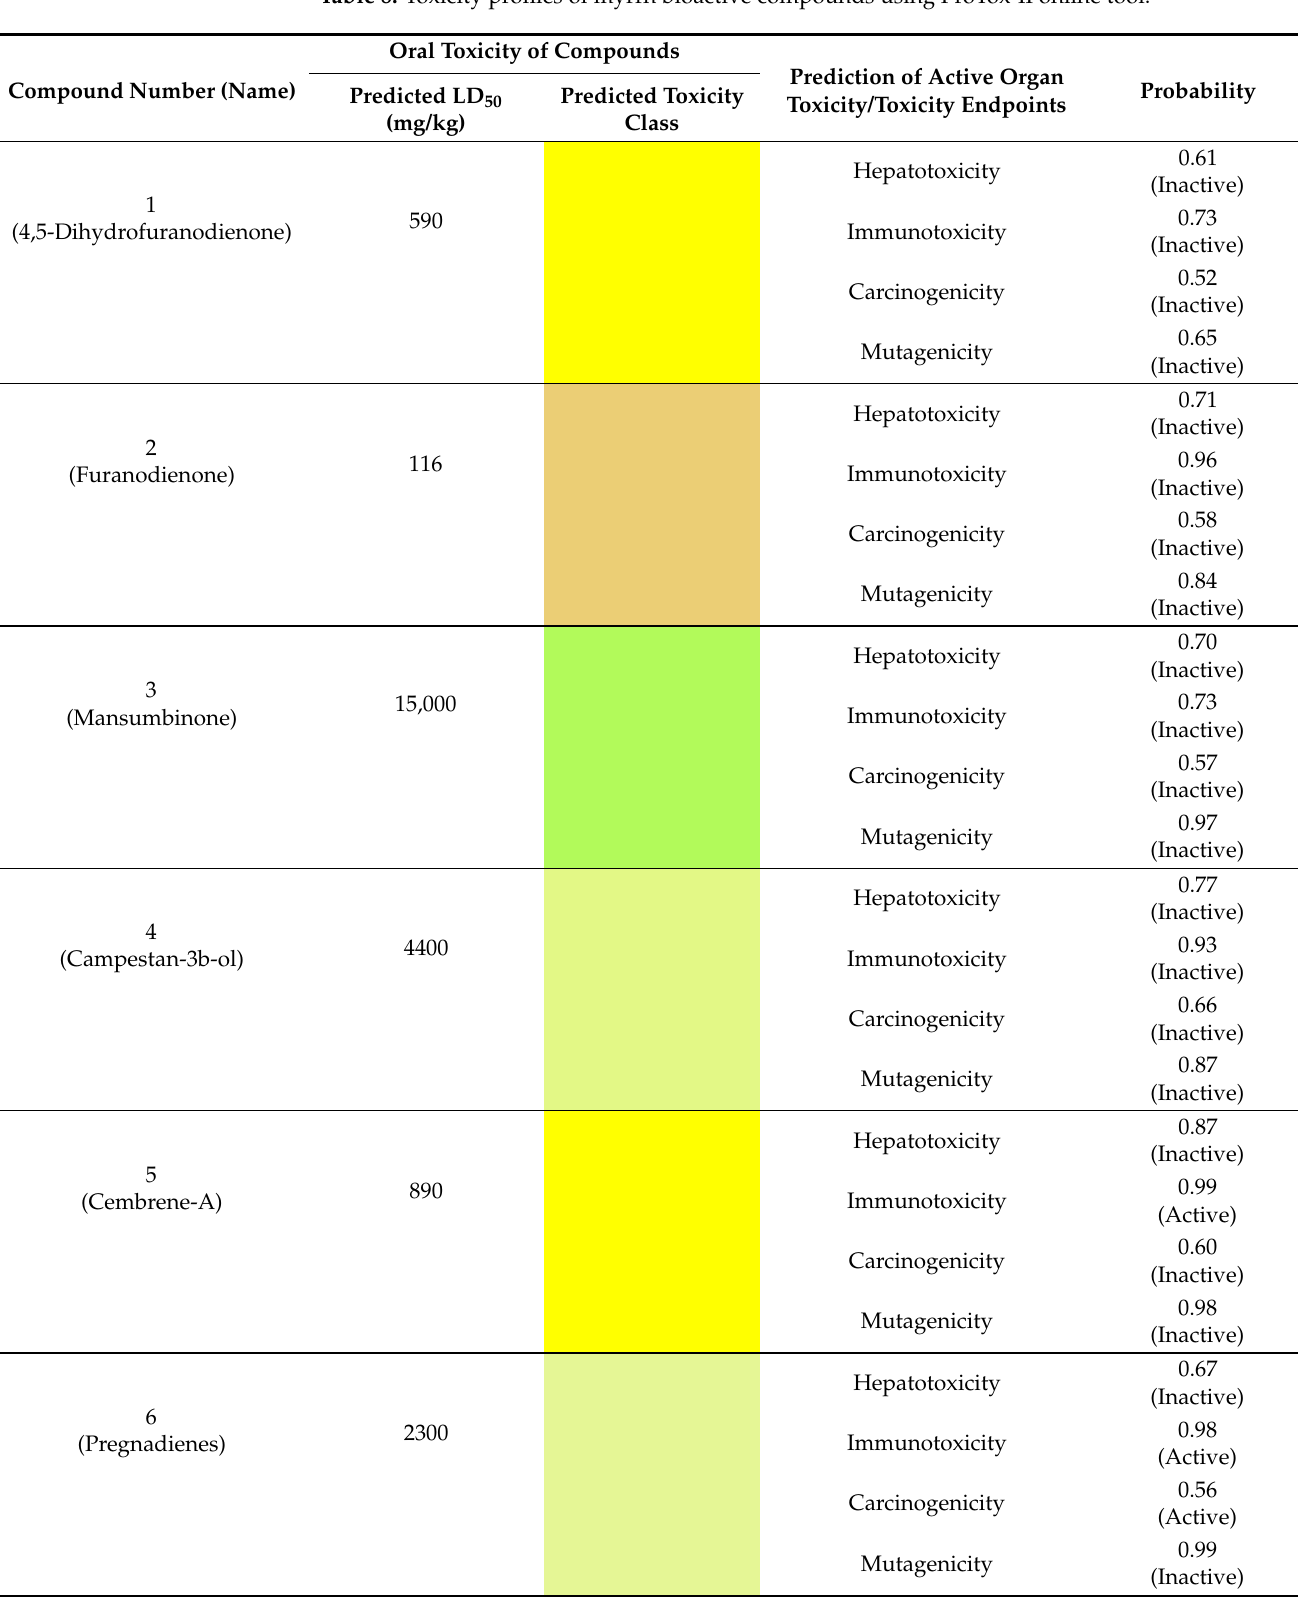
Table 8. Toxicity profiles of myrrh bioactive compounds using ProTox-II online